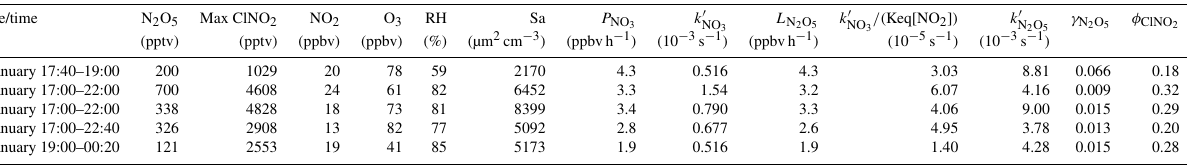
Table 2. Average N 2 O 5 concentration values, N 2 O 5 uptake coefficients, ClNO 2 yields, and other related parameters and maximum ClNO 2 concentration values in the early nighttime for the five selected nights.